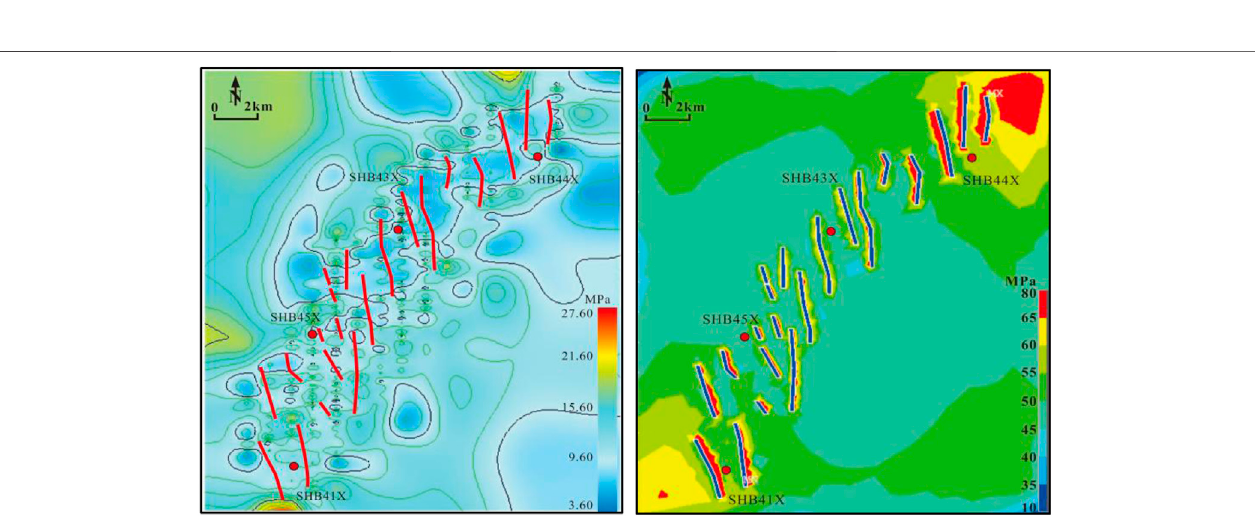
Frontiers in Earth Science |